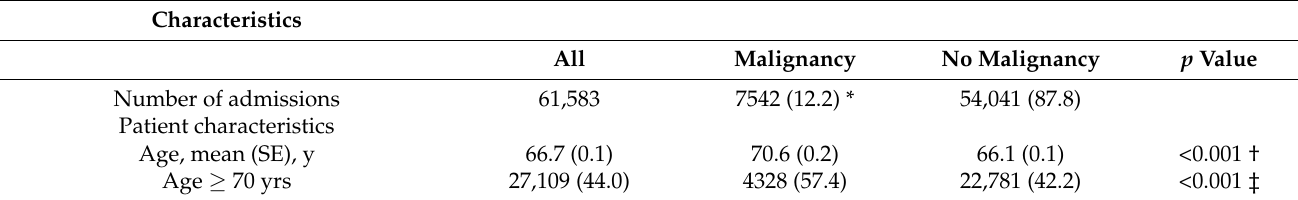
Table 1. Baseline characteristics of Takotsubo Syndrome Patients with or without Malignancy.